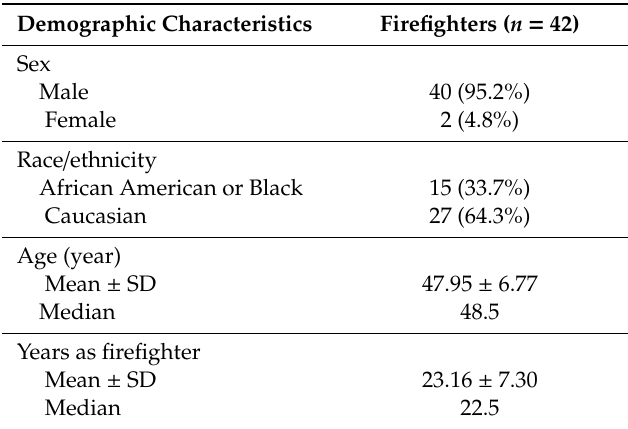
Table 1. Basic demographic characteristics.